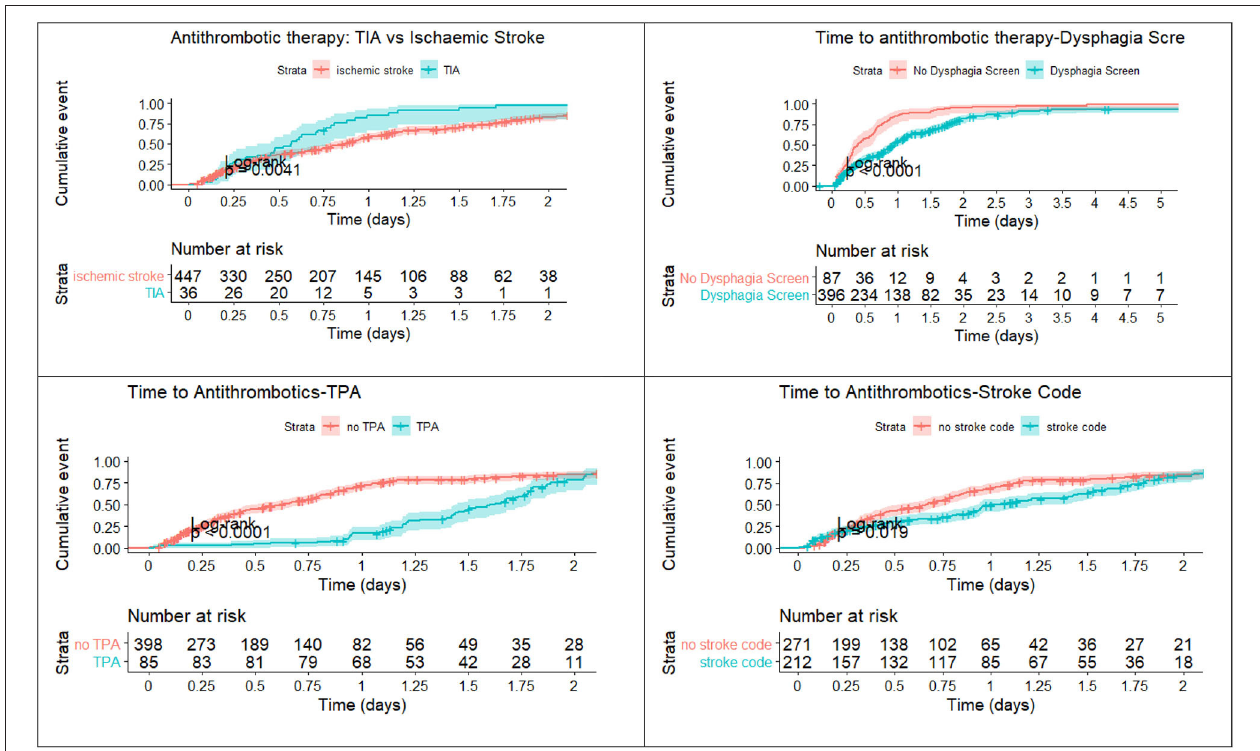
FIGURE 1 | Time to antithrombotics. Patients with TIA received aspirin earlier than those with ischemic stroke. Weekend had no effect on administration of aspirin. The x-axis is truncated at day 2.